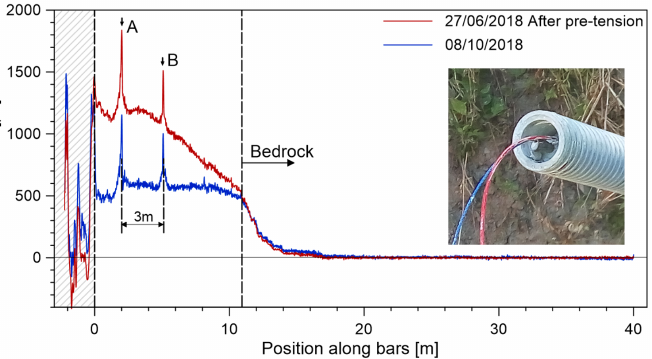
Figure 2. Axial strain along one soil anchor instrumented with a fiber optic and probed by a commercial OFDR system; the anchor was measured after some pre-tension was applied at the time of installation (blue curve) and then after about three months (red curve). In the inset, a picture of the head of a composite anchor equipped with fibers. The analysis of the strain profile shows that approximately one-quarter of the anchor length is activated up to the stable bedrock. Furthermore, the system’s high spatial resolution allows identification of the coupling nuts of the anchors, where peak strain values are recorded (marked by A, B), suggesting that those are points with lower stiffness (adapted from Ref.